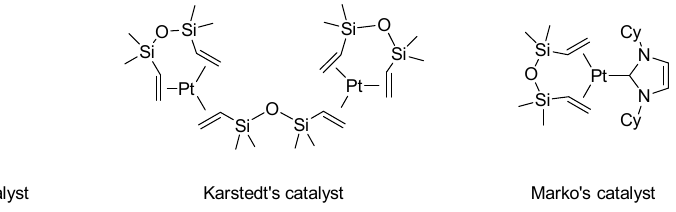
Figure 1. Representative platinum-based hydrosilylation catalysts.